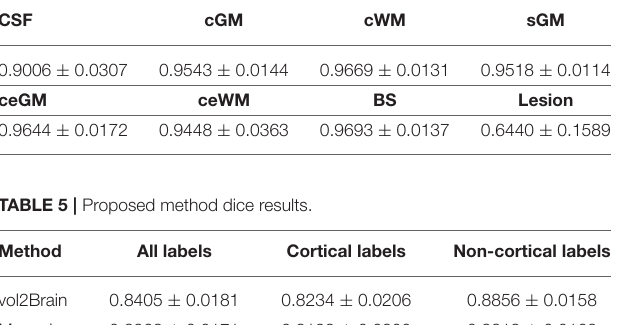
TABLE 4 | Proposed method dice results for each brain tissue.